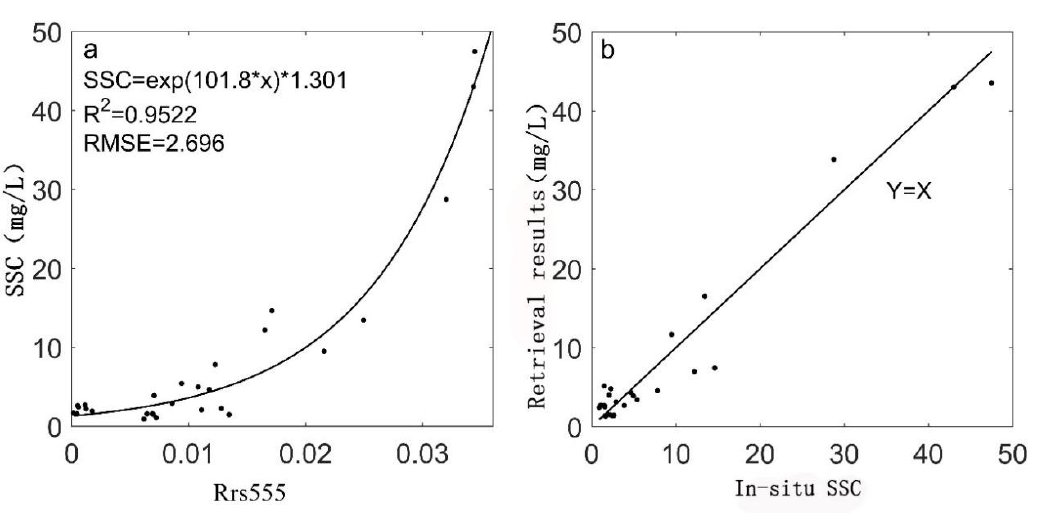
Figure 5. A fitting relationship between in situ SSC and Rrs555. The remote sensing retrieval formula ( a ) and the verification results ( b ).